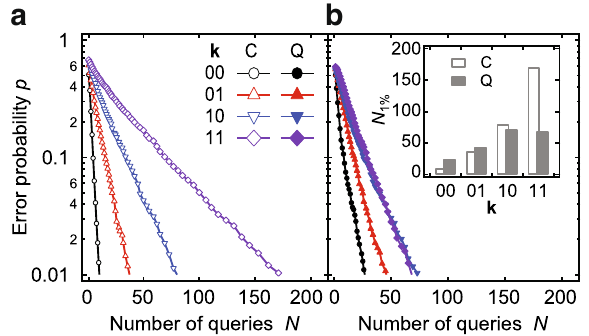
Fig. 2 Error probability p to identify a 2-bit oracle k as a function of the number of queries N . For both classical a and quantum b learners, one of the four oracles k is applied, followed by the simultaneous measurement of all qubits. Hadamard gates are applied prior to measurement in the quantum case (Fig. 1b). See text for a description of the solvers in the two scenarios. Inset: number of queries N 1% ( k ) required to reach 1% error for the classical ( empty bars ) and quantum ( solid )